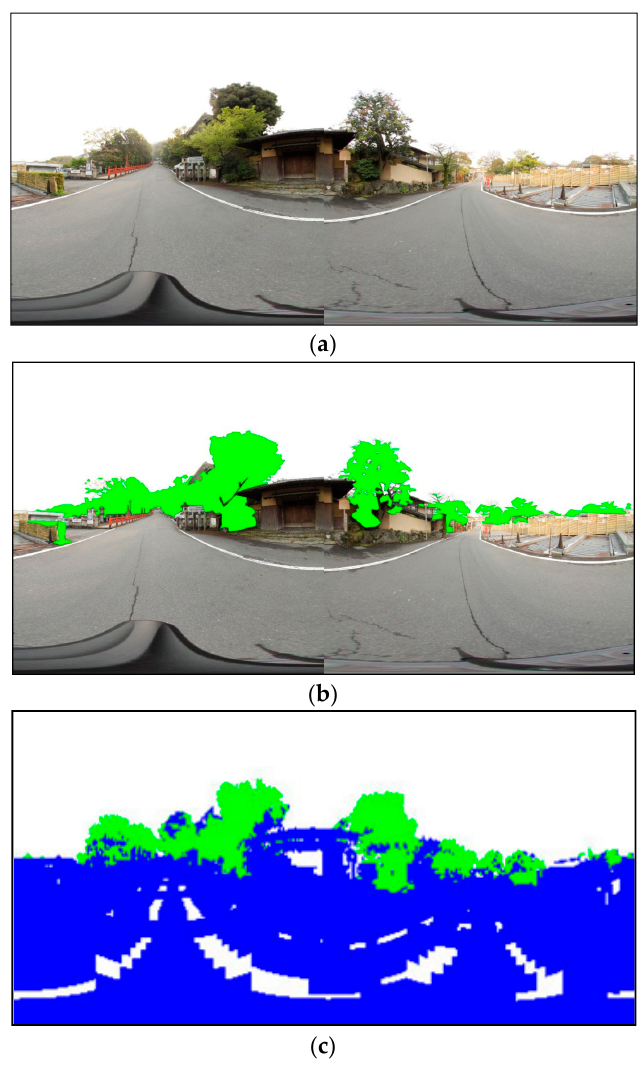
Figure 12. ( a – c ) Comparison of ground truth and occlusion map at P11 (shown in Figure 1). See Figure 11 for a description of each panel. ( b ) Actual GSR = 7.1%. ( c ) Estimated GSR = 7.6%.